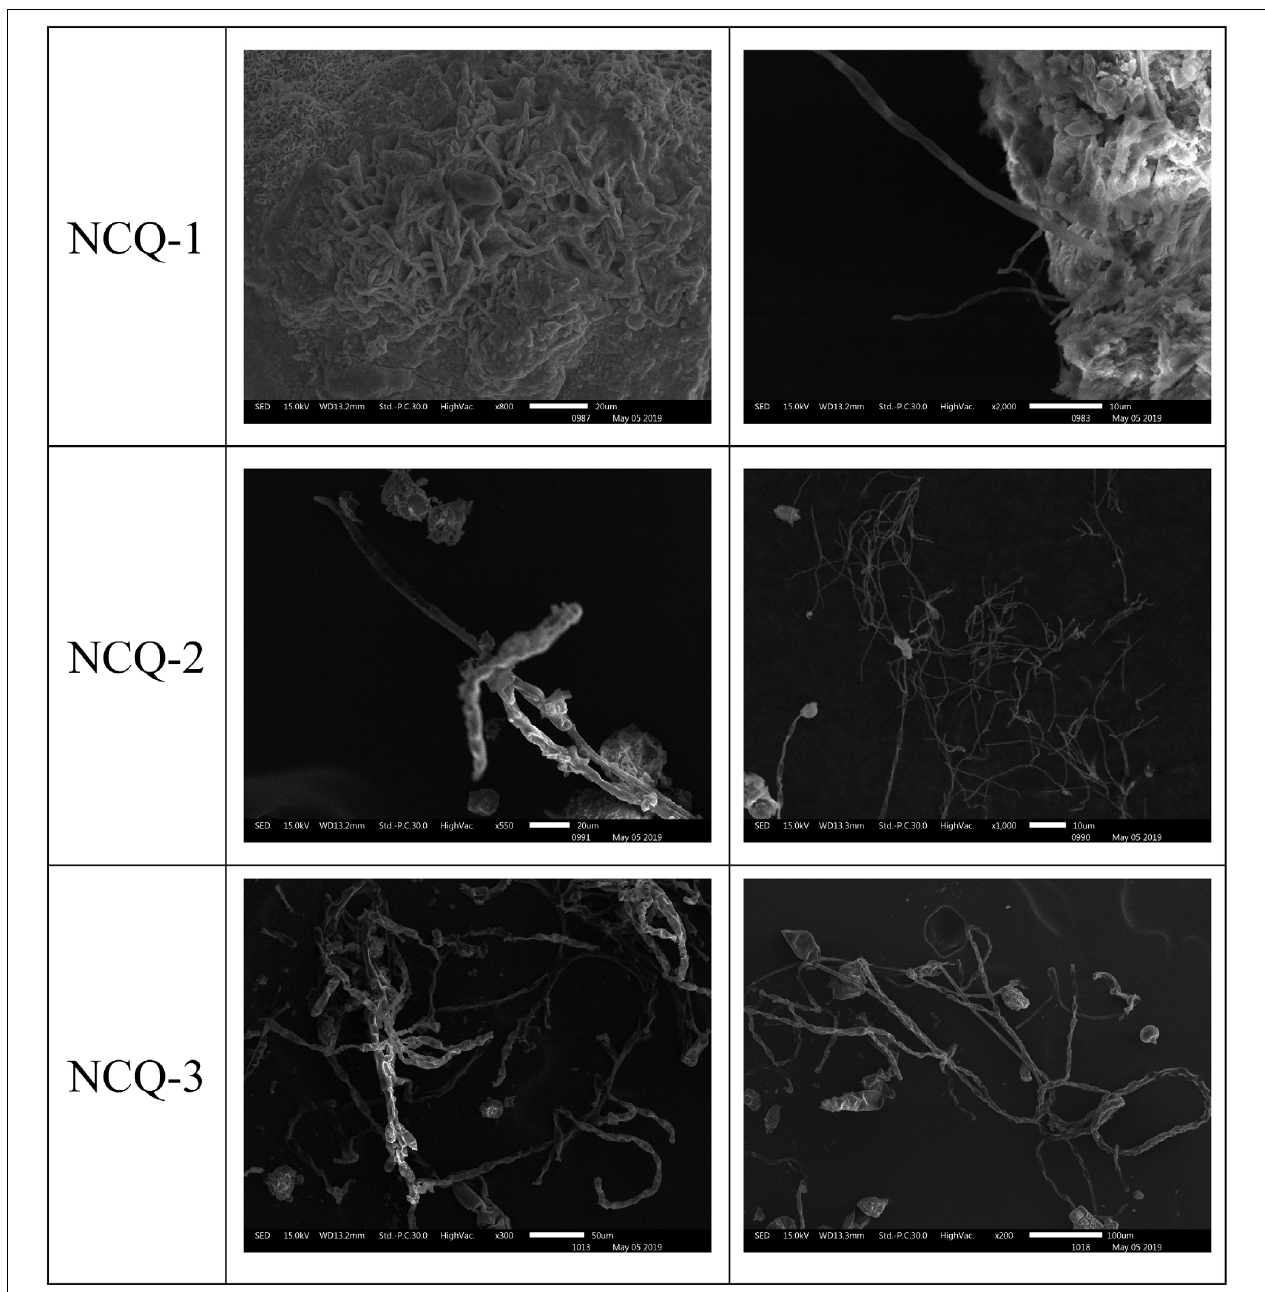
FIGURE 6 | Scanning electron microscopy (SEM) images of a large number of hyphae and cells with a structure similar to algae observed on the